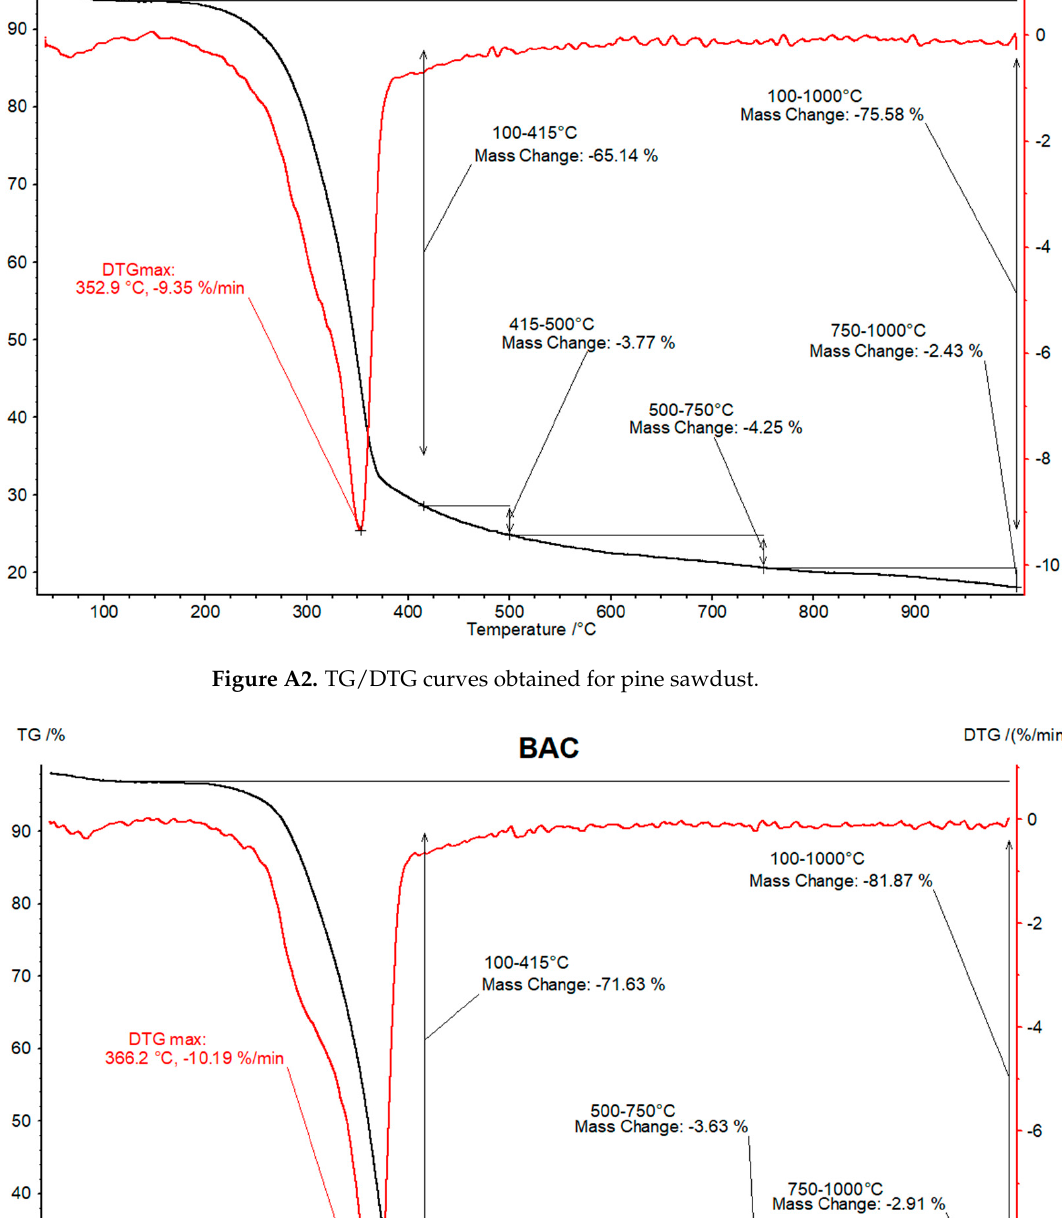
Figure A1. TG/DTG curves obtained for coal blend.